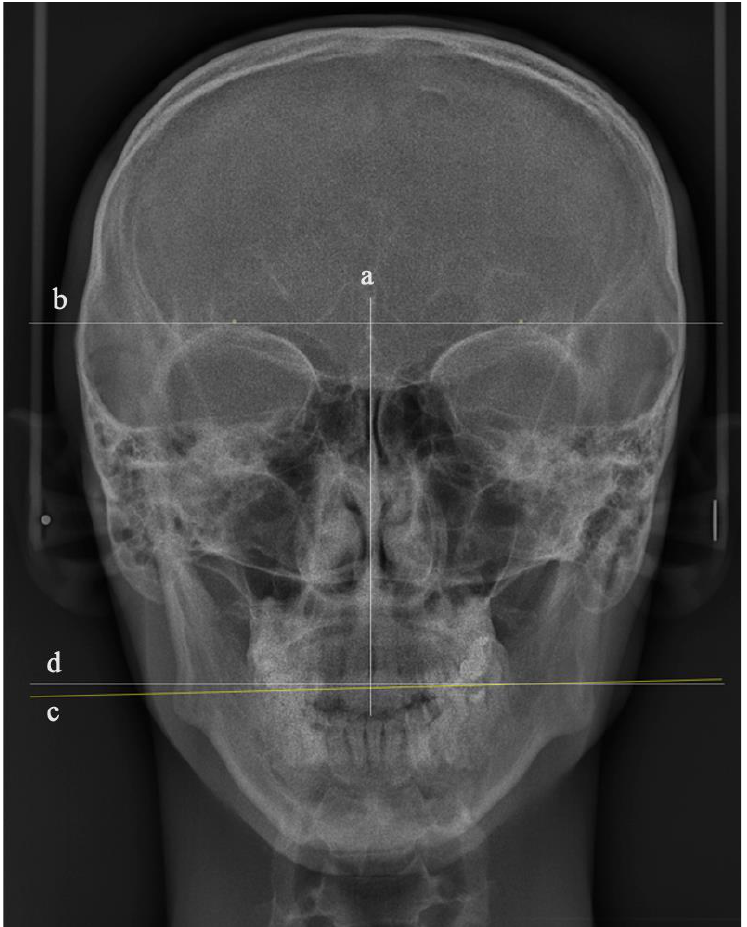
Figure 2. Illustration of the tracing lines of the PA cephalometric images: ( a ) vertical line representing the facial midline, ( b ) true horizontal line, ( c ) occlusal plane line, and ( d ) tangent parallel to the true horizontal line.